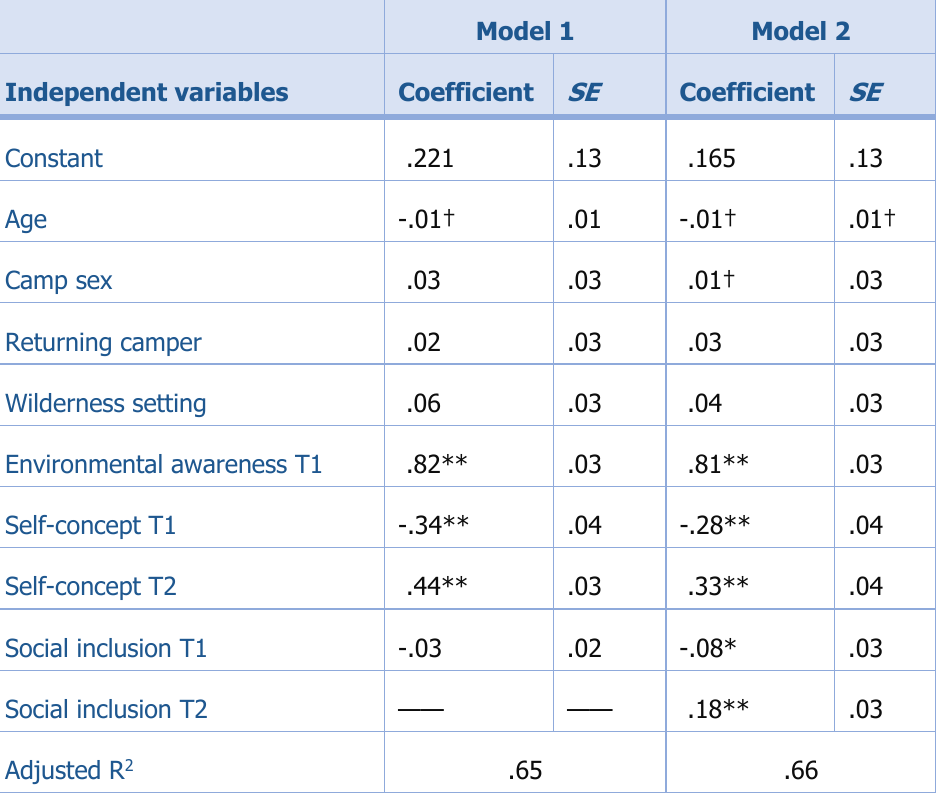
Table 1. Unstandardized Regression Coefficients for Regression Models Examining Associations of Environmental Awareness with Self-Concept and Social